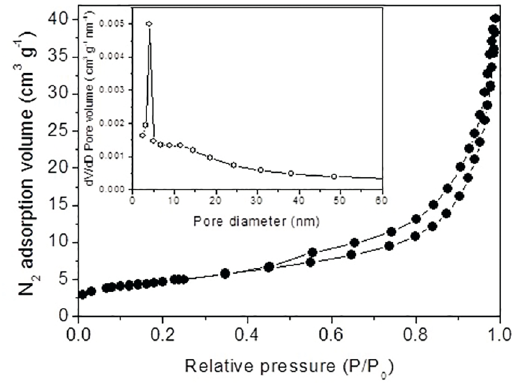
adsorption/desorption isotherms of kaolin and the Figure 7. N 2 corresponding pore size distribution (inset).